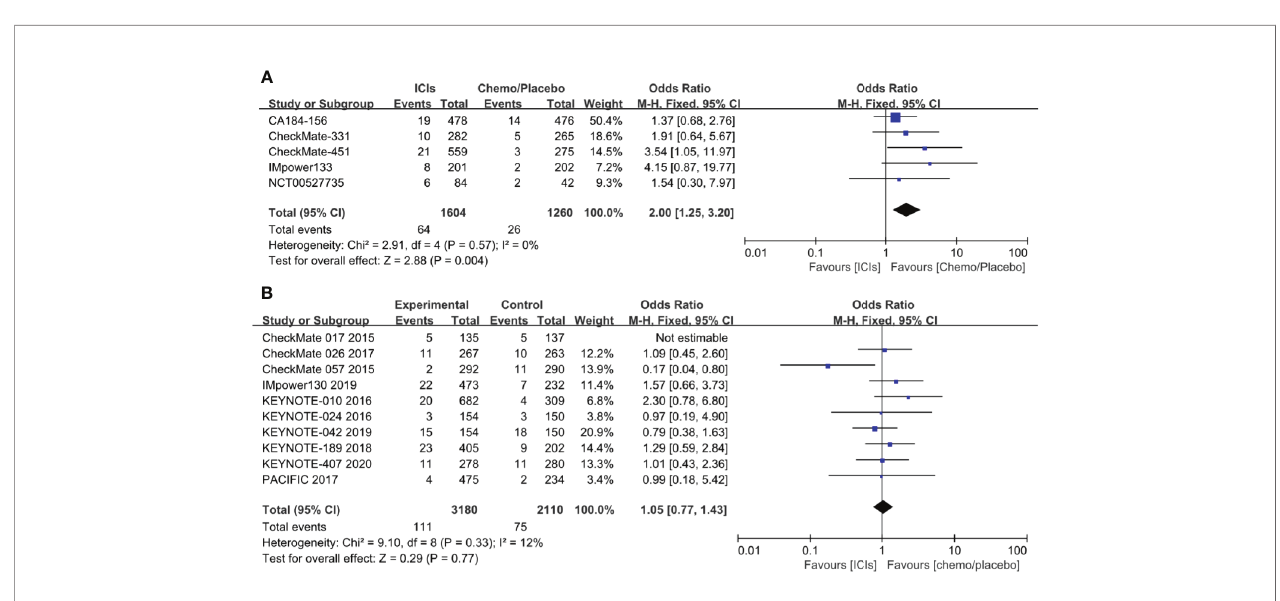
FIGURE 3 | Pooled analysis of neuromuscular toxicity in SCLC (A) and NSCLC (B) .